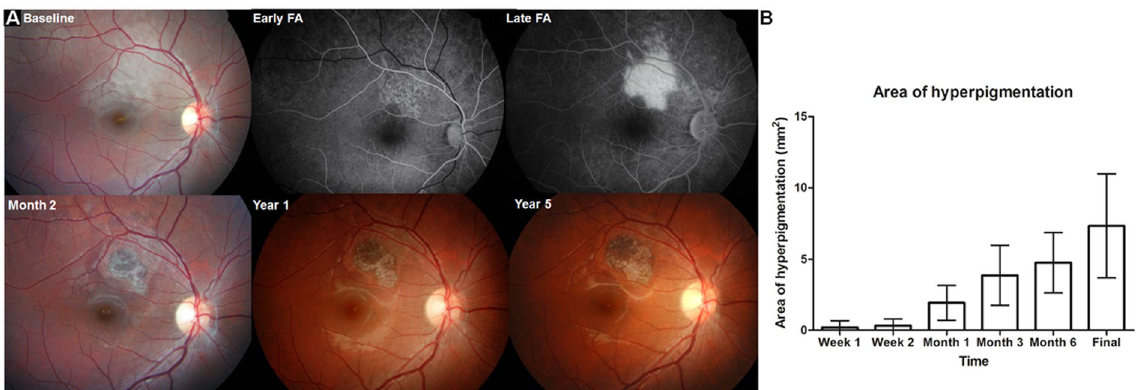
Figure 2. Baseline and follow-up fundus photographs demonstrating the development and progression of retinal pigment epithelium sequelae and their association with baseline fluorescein angiography (FA) findings. ( A ) At baseline (top row), a cream-coloured change of the fundus was noted in the superior retina. FA reveals a localised hyperfluorescent lesion with fine hypofluorescent clumpings at the early phase and leakage over the lesion at the late phase. Subsequent fundus photographs (bottom) showing amorphous hyperpigmentation within a well-demarcated hypopigmented lesion, which corresponds to the area of leakage on FA. The hyperpigmentation gradually increased in size over 5 years. ( B ) The mean area of hyperpigmentation in eyes showing pigmentation gradually increases over time. Error bars indicate 95% confidence